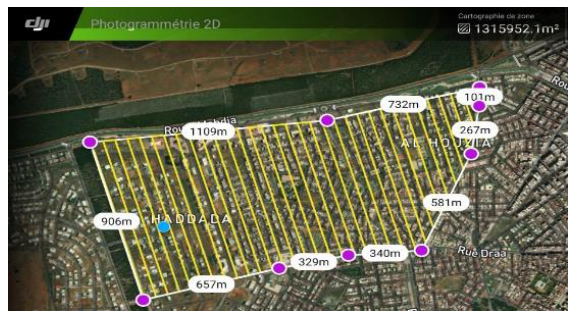
Figure 3 . Planning of the aerial shooting.